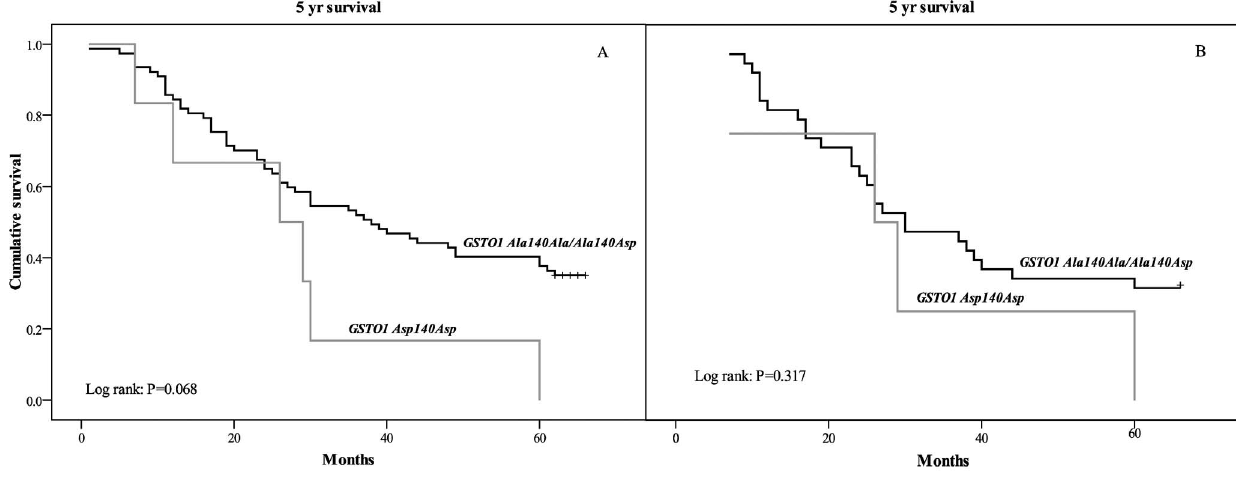
Figure 3. Survival analysis Kaplan–Meier curves according to GSTO1 polymorphism for overall mortality (A), as well as mortality of TCC patients on chemotherapy (B).